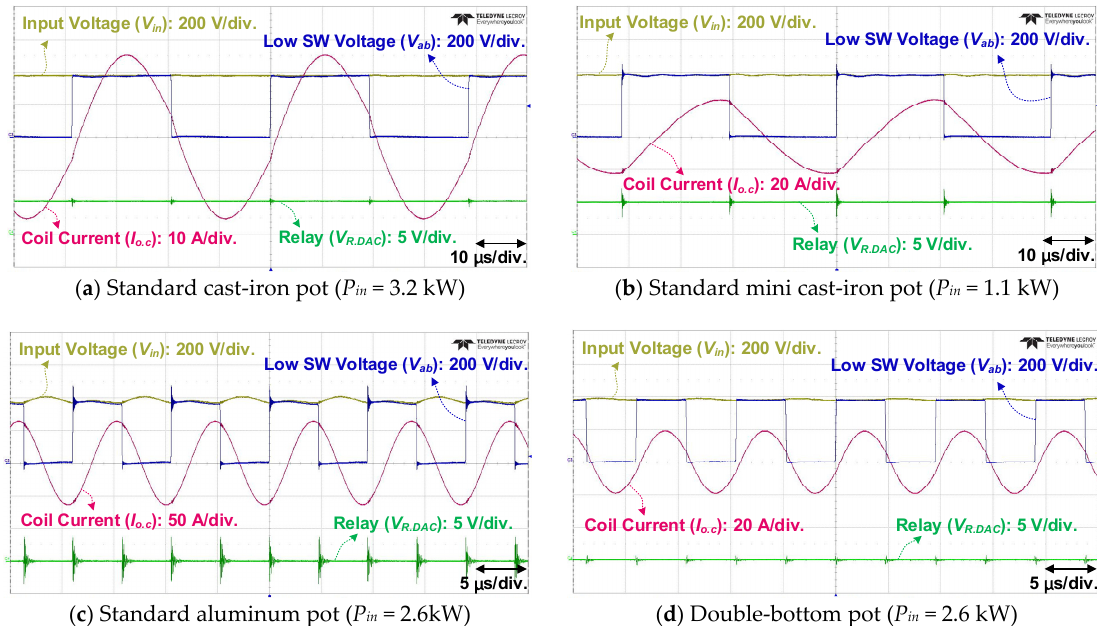
Figure 16. Waveforms of power-factor correction (PFC) circuit.